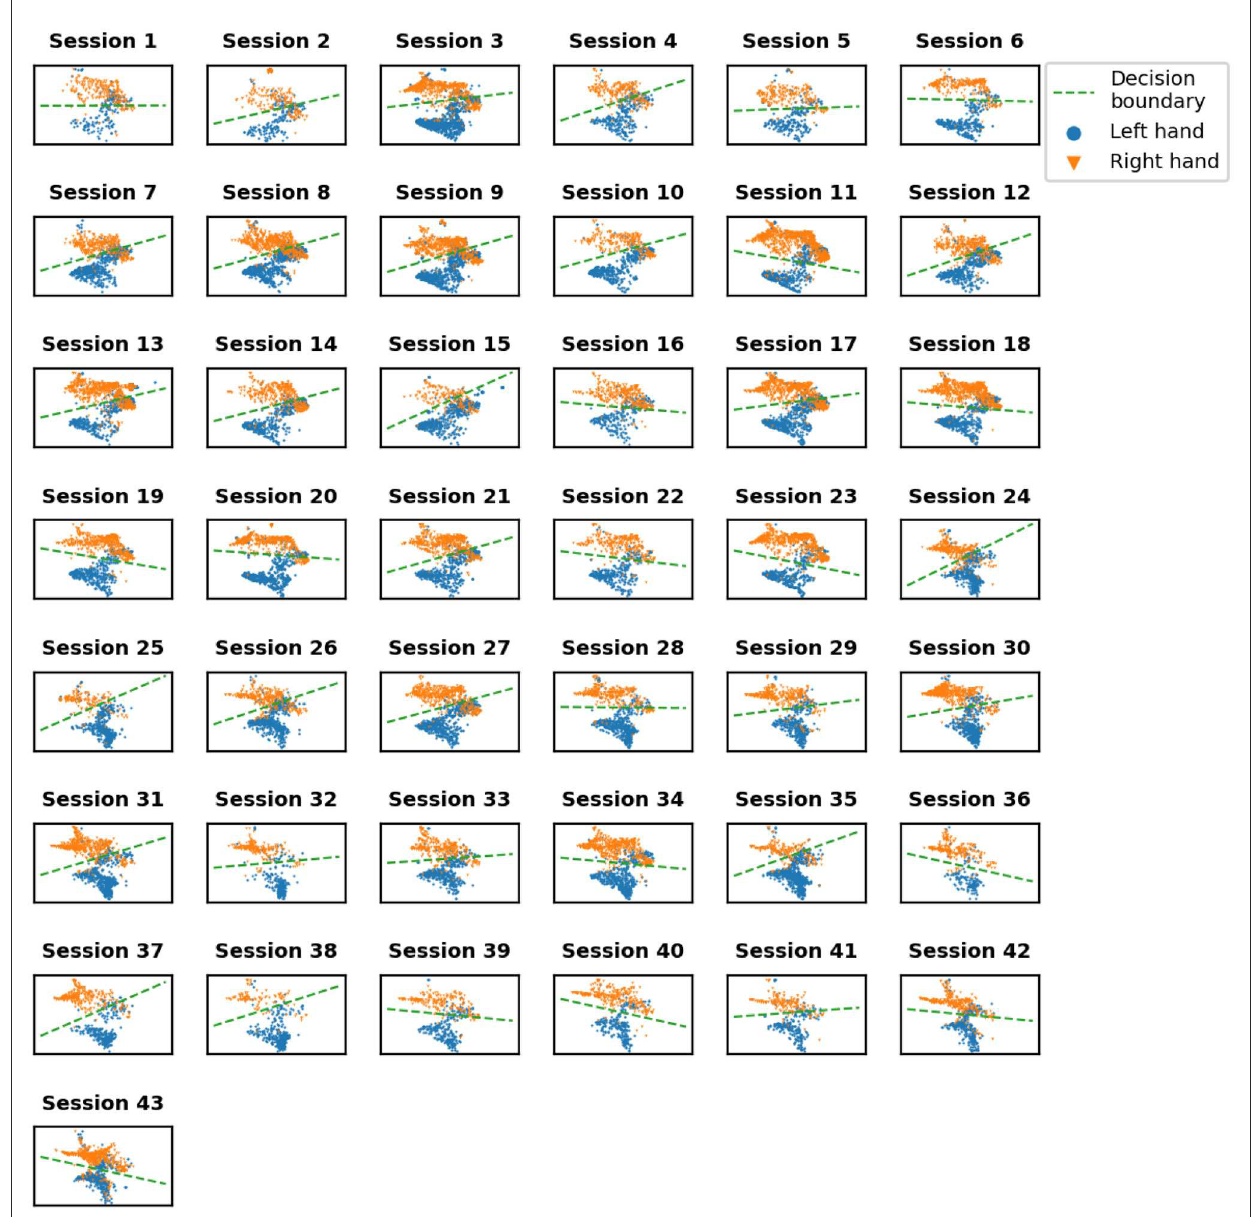
FIGURE4 Visualization of 2D embedding of left and right hand data obtained using UMAP. Green dashed line showes SVM decision boundary.